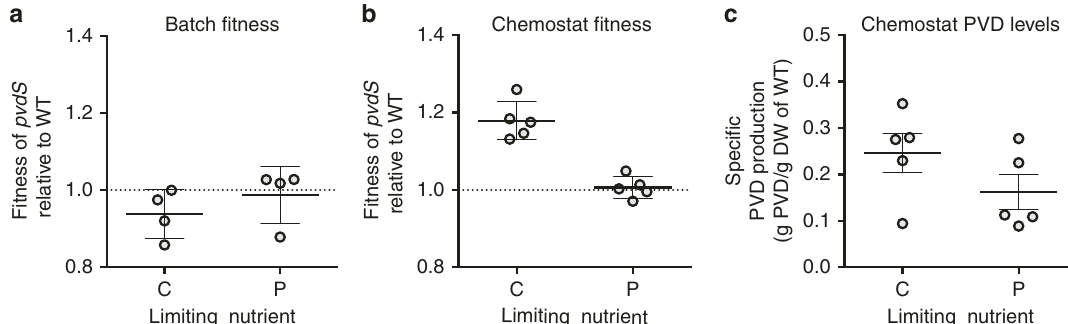
Fig. 3 Fitness costs of PVD production according to growth-limiting nutrient and culturing format. a , b Relative fi tness of the P. aeruginosa pvdS mutant in a batch culture and in b chemostat culture. Co-cultures of the WT and the pvdS mutant were initiated at a 1:1 ratio in either C-MEM or P-MEM. The duration of growth was 24h in batch and 6 days in chemostat culture. Relative fi tness w was calculated as the ratio of average growth rates, considering initial and fi nal strain frequencies ( w > 1 indicates an increase in mutant frequency, w < 1 indicates a decrease in mutant frequency, and w = 0 indicates no change in mutant frequency over time). Relative fi tness is signi fi cantly different from 1 only in C-MEM chemostat culture, but not in C-MEM batch, P-MEM batch, and in P-MEM chemostat cultures (one-sample t -test; p = 0.0013, 0.15, 0.77, and 0.65, respectively). Relative fi tness in C-MEM is signi fi cantly different than in P-MEM in chemostat culture but not in batch culture (two-sample t -test, p = 0.00010 and 0.34, respectively). c Speci fi c PVD production levels in chemostat culture. Shown are the average amounts produced by the WT subpopulation over time. PVD levels in C-MEM were not signi fi cantly different than in P-MEM (two-sample t -test, p = 0.18). Each individual data point represents a separate biological replicate. Error bars indicate SEM